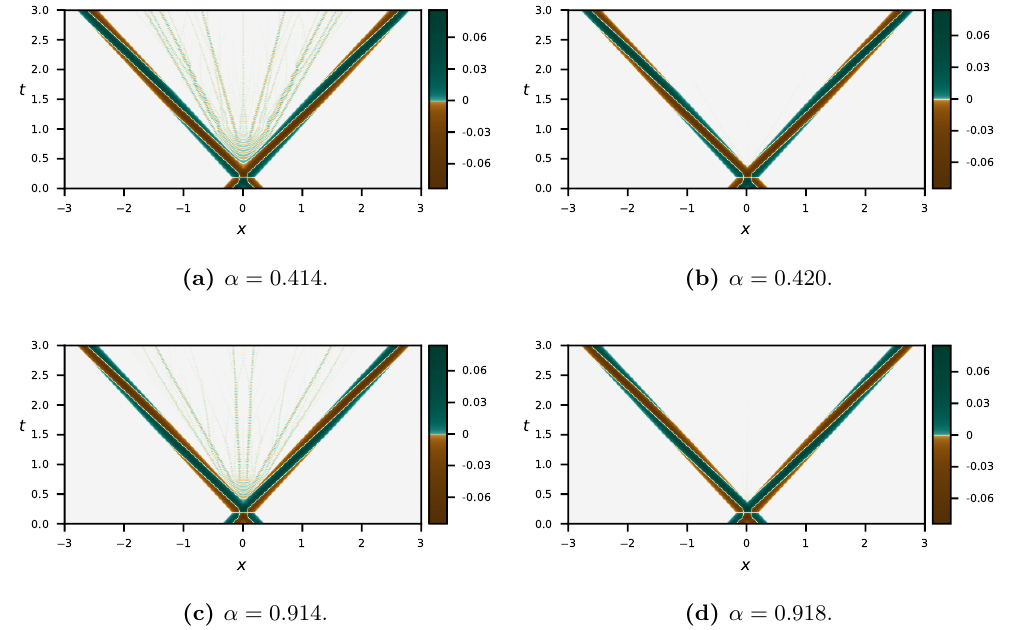
Figure 26 . The scattering process for the initial symmetric con(cid:12)guration containing oscillons with speed V = 0 : 93, velocity of the border v = 0 : 02 for di(cid:11)erent phases (cid:11) .